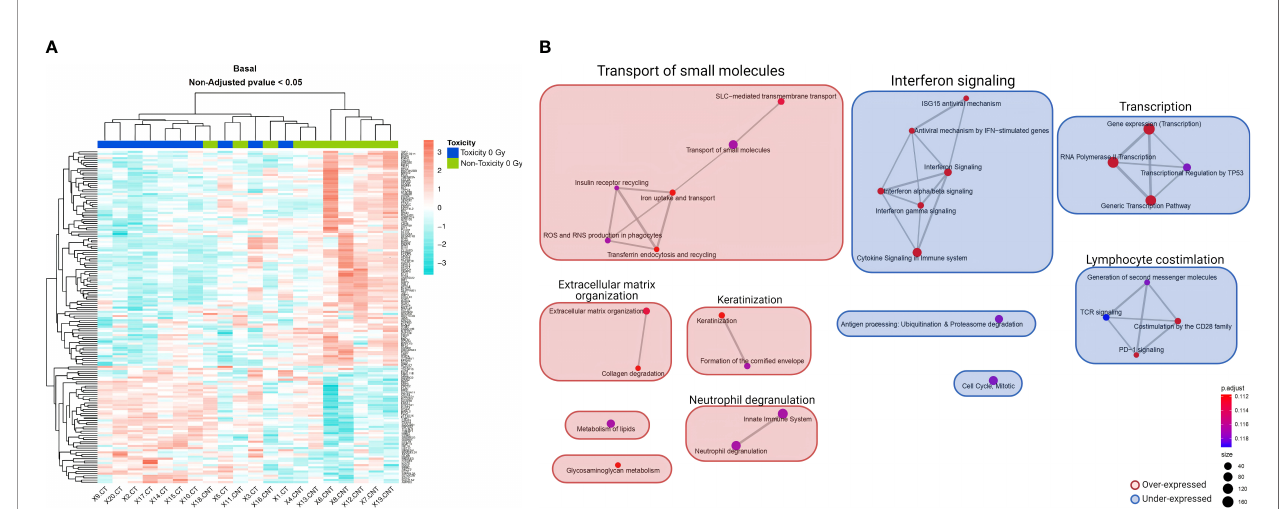
FIGURE 1 | Heatmap and GSEA of basal non-irradiated cells comparing patients with late skin toxicity to normal responders. (A) A different expression pattern between patients with toxicity (dark blue) and without toxicity (green) of baseline expressed genes with non-adjusted p-value < 0.05 is suggested by hierarchical clustering classi fi cation of patients (columns). (B) The enrichment map allows the visualization of the general expression landscape of the toxicity group compared with the non-toxicity group in basal conditions. The key is shown in the bottom right of the fi gure. The map is constructed with an FDR cutoff of <0.25. Each node corresponds to a gene set from the GSEA; its size represents the number of genes in the gene set and its color the p -value. The thickness of the lines connecting the nodes is proportional to the number of genes that overlap in the gene set. Clustering among the various gene sets is visualized with boxes over the nodes. Those sets that are upregulated in patients with toxicity are shown in red and those downregulated are shown in blue. CT, control non-irradiated sample in toxicity patients; CNT, control non-irradiated sample in non-toxicity patients; GSEA, gene set enrichment